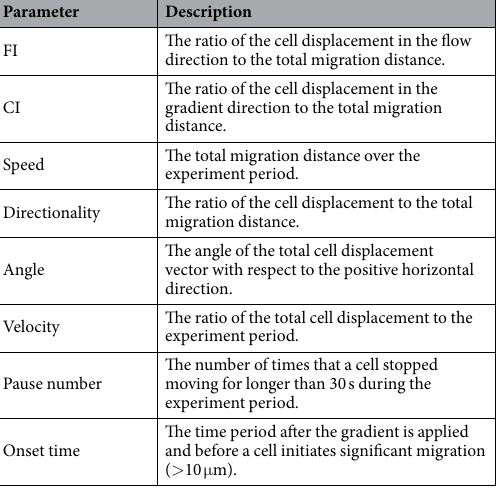
Table 1. Cell migration parameters used for PCA. The names of the parameters are listed in the left column and the corresponding definitions are given in the right